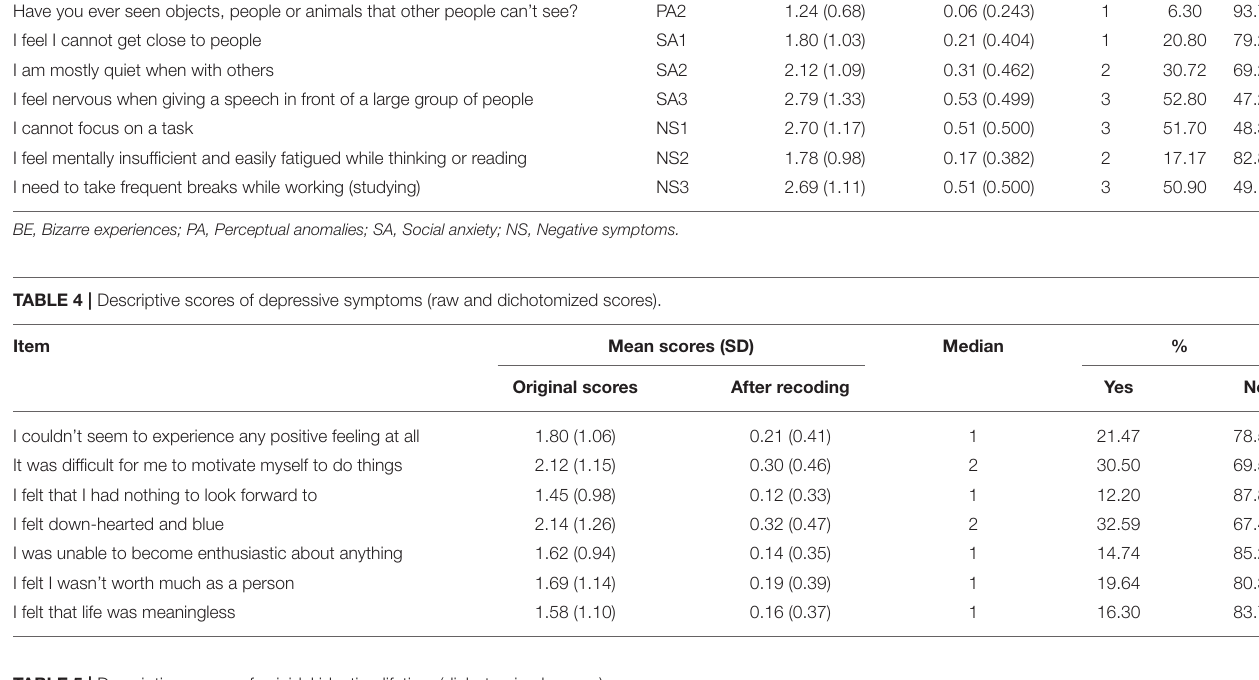
TABLE 5 | Descriptive scores of suicidal ideation lifetime (dichotomized